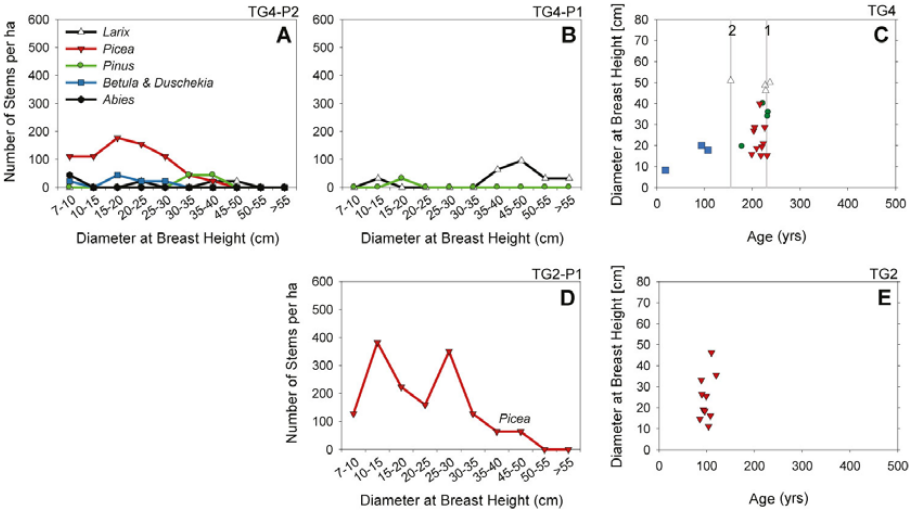
Fig. 5 Fig. 5. Diameter at breast height of tree species growing on adjacent sites without (A) and with (B) a recent surface fire, and the relation between diameter at breast height and tree age (C) , and density of trees as related to breast height diameter (D) and age (E) in a pure stand of Picea obovata which regenerated on alluvial loam. Symbols are explained in (A) .